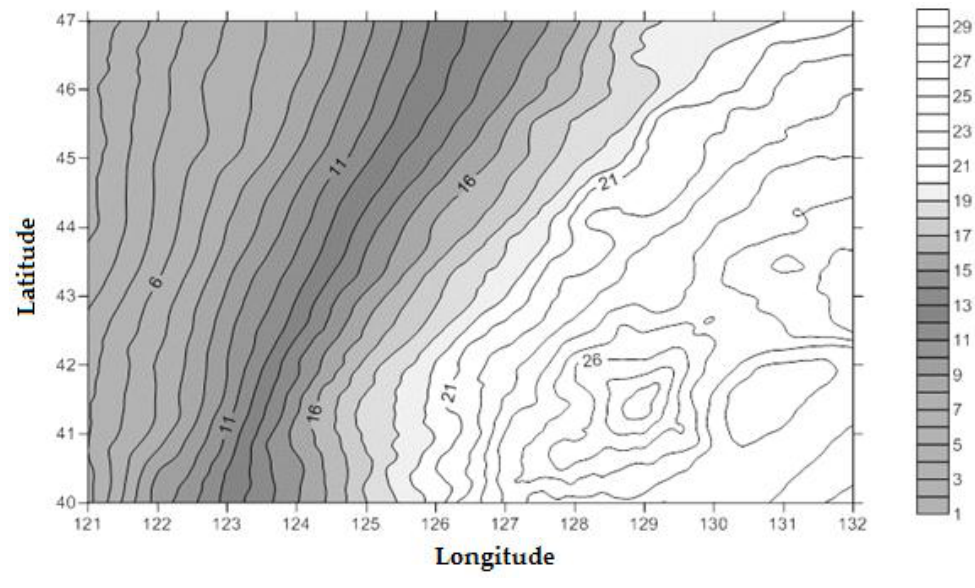
Figure 4. Geoid undulation in Jilin Province with respect to CGCS2000 (m).